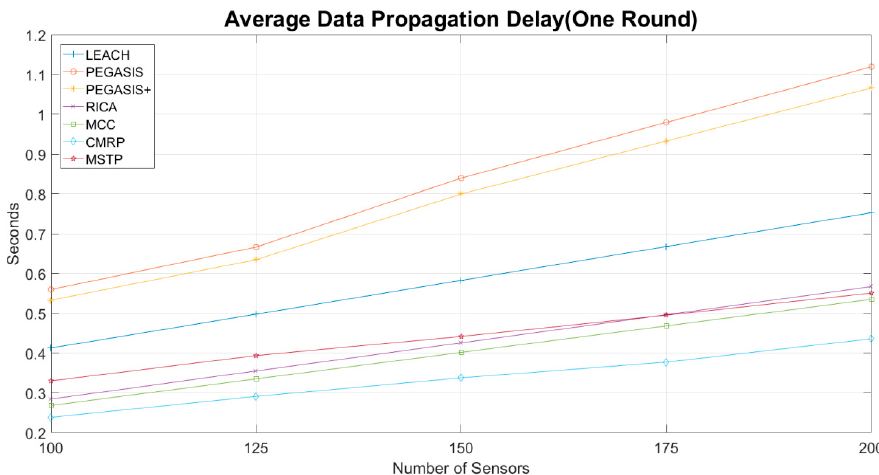
Figure 8. Average data propagation delay.